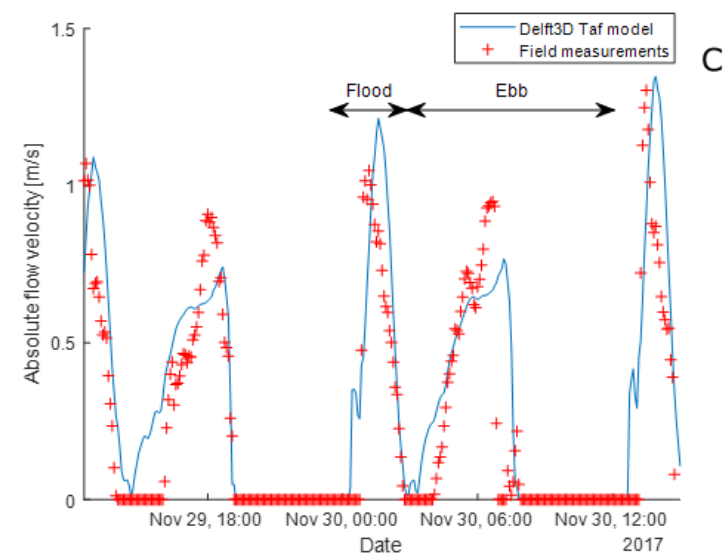
Figure 6. Taf Estuary computational model validation. ( a ) Comparison of modelled water depth with field measurements in the main estuary channel, next to St. John's Hill. ( b ) Comparison of modelled flow velocity with field measurements in the main estuary channel, at the exact location where the velocity meter was anchored. ( c ) Same as B, but at a location on the Laugharne saltmarsh, in the proximity to the channel. In all plots, the blue line depicts modelled outputs and the red line/red crosses depict measured values. NSE, Nash–Sutcliffe efficiency coefficient; RMSE, root mean square error.